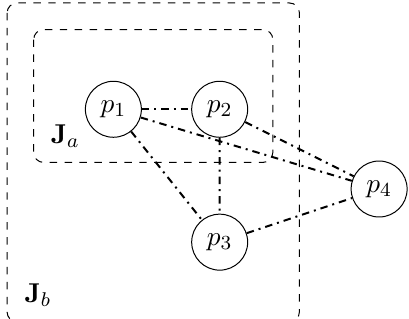
Figure 1. A schematic diagram of the graph representation of a jet used in this paper. Each vertex corresponds to a jet constituent, and a line between two circles represents the variable calculated from the two vertices. Each dashed rectangle represents a subjet that contains the enclosed jet